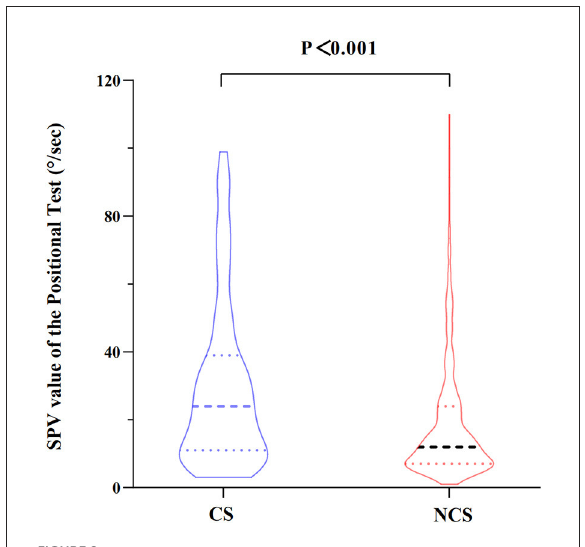
FIGURE2 Comparison of maximum slow phase velocity (SPV) of the nystagmus evoked by the position tests between the two groups.